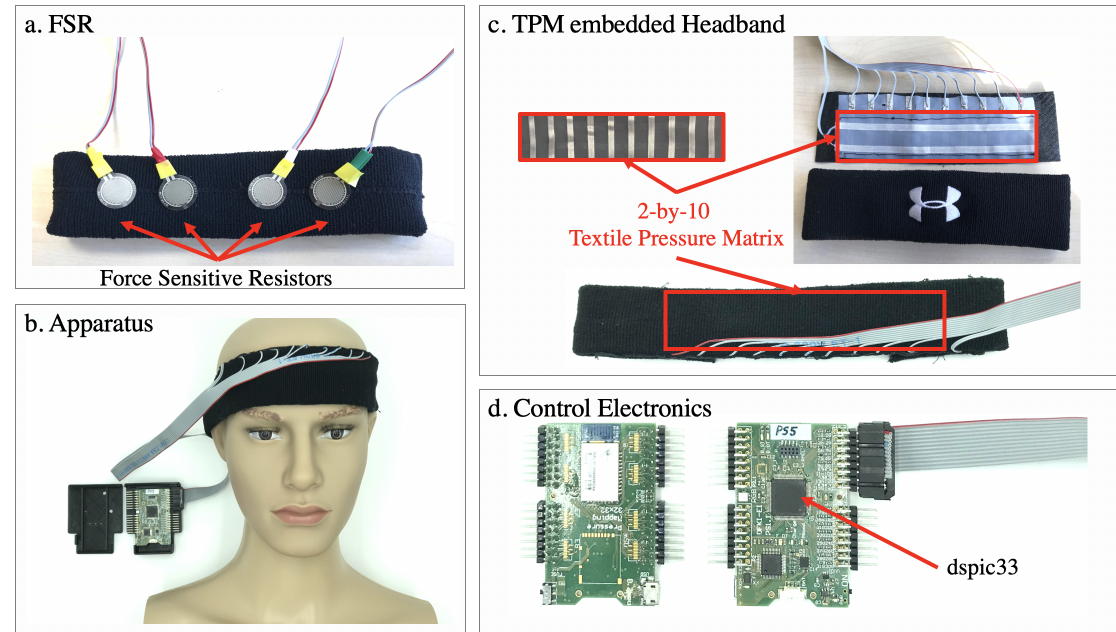
Figure 1. ( a ) Prototype with four force-sensitive resistors (FSR) that was rejected after comparing with the new approach. ( b ) The apparatus used for our experiments shown with the textile pressure mapping sensors embedded inside the headband. ( c ) The interior of the headband with a 2-by-10 textile pressure mapping (TPM) matrix, isolated from the user’s skin with textile tapes. ( d ) The electronics hardware, built around a dspic33